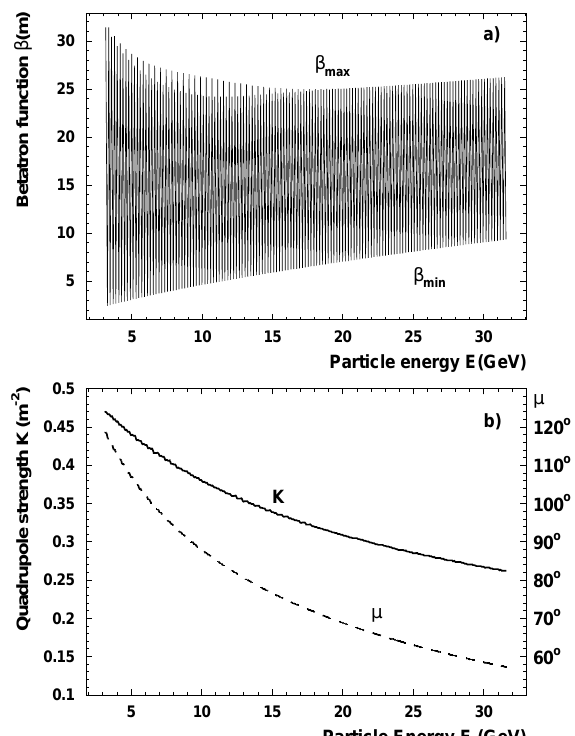
FIG. 1. The fully matched beta envelope along the main linac of the S-band linear collider with the chromaticity scaled as the square root of g (cid:48) (cid:121) g (a) and the corresponding variation of the phase advance (solid line) and quadrupoles strength (dashed line) along the main linac